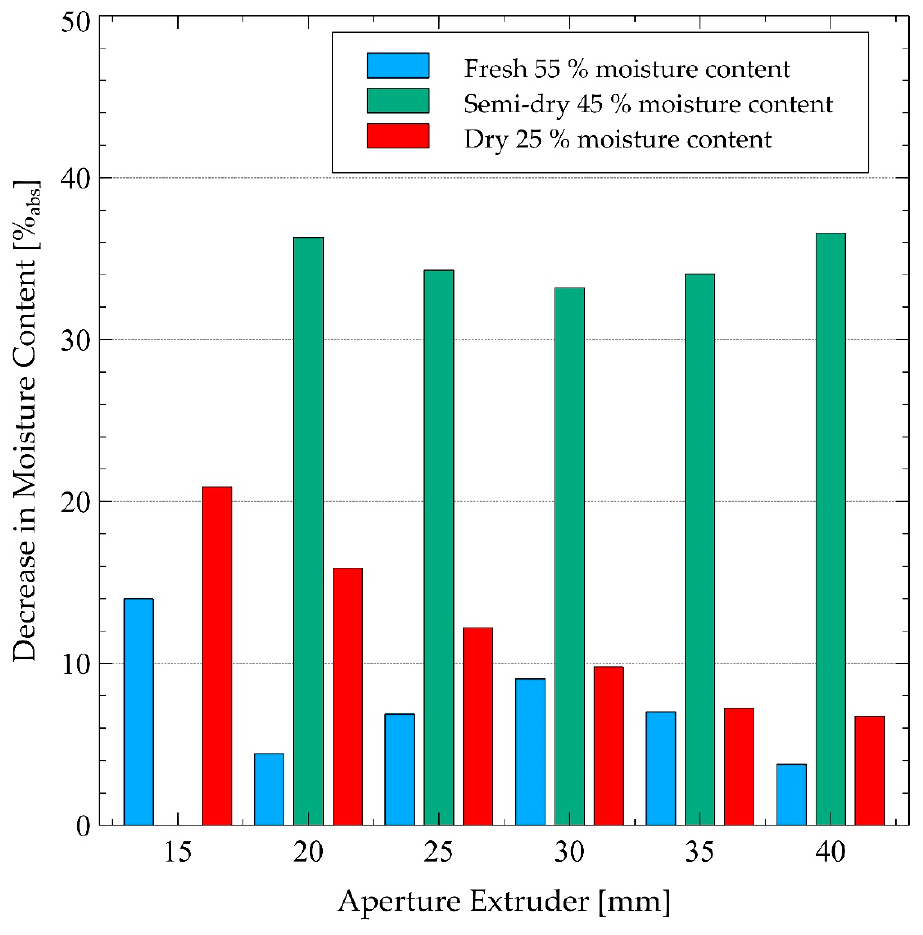
Figure 8. Decrease in moisture content during extrusion [%] in relation to moisture content prior to extrusion.